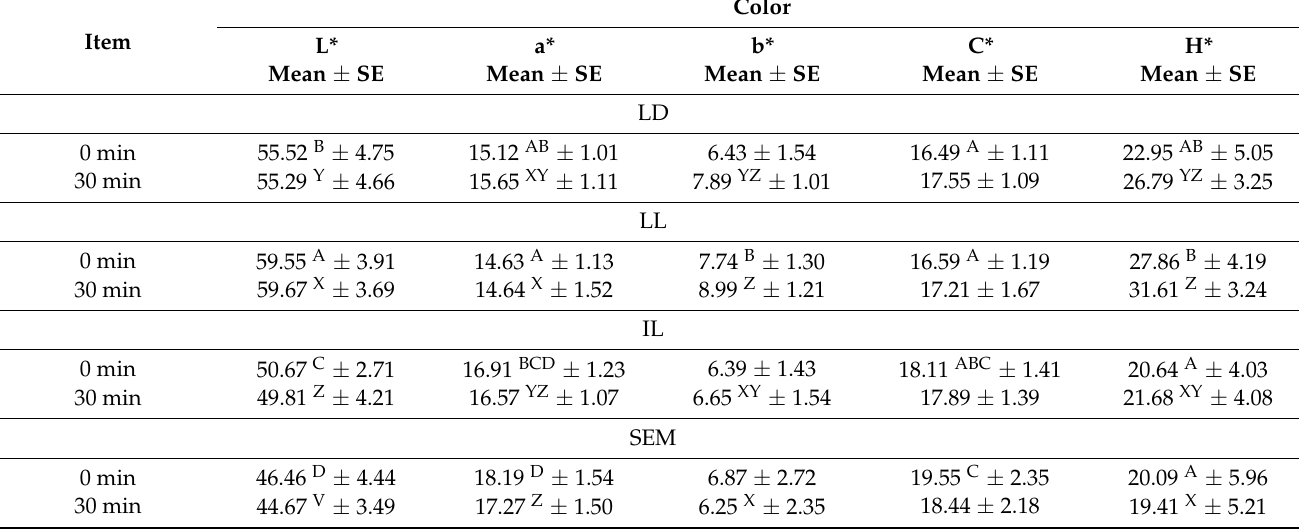
Figure 1. Changes in pH measurements including bloom time and muscles. * p ≤ 0.05, ** p ≤ 0.01—difference between pH 0min and pH 30min within the same muscle; A,B,C,D —differences between muscles for pH 0min , p ≤ 0.01; X,Y,Z —differences between muscles for pH 30min , p ≤ 0.01; LD— Longissimus dorsi , LL— Longissimus lumborum , IL— Iliacus , SEM— Semimembranosus , CT— Cutaneous trunci , LTD— Latissimus dorsi . Table 1. Changes in color parameters with regard to bloom time and muscle